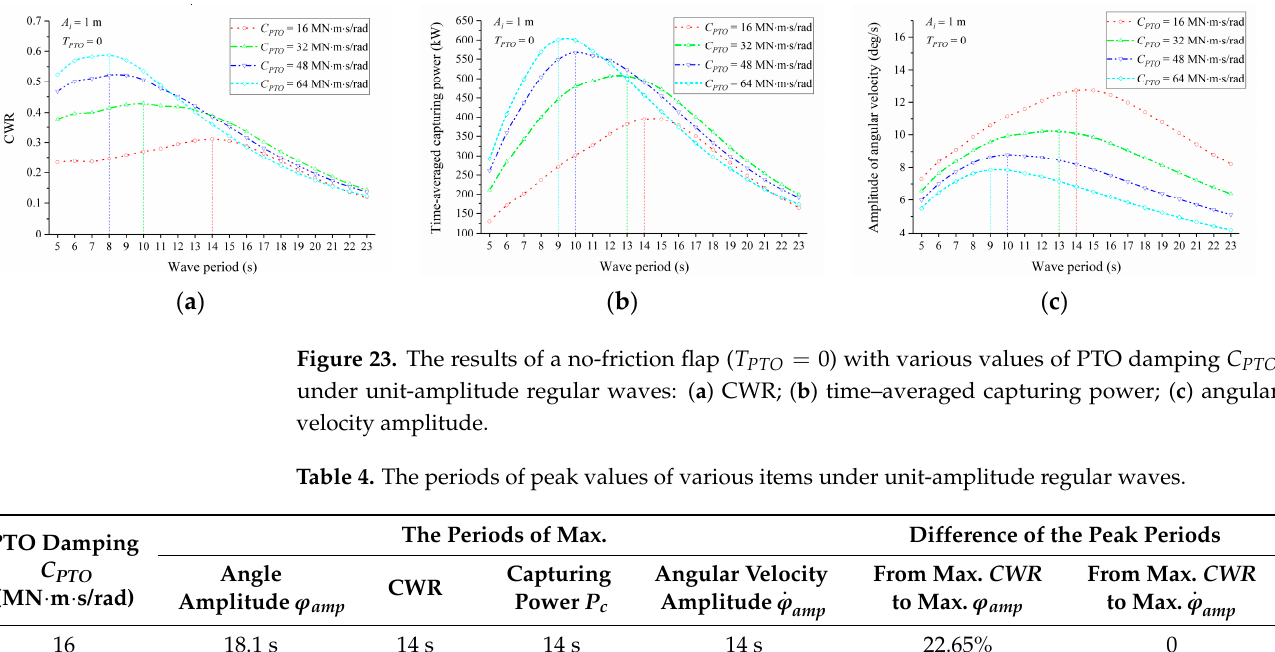
Figure 22. Time–history of the ratios of wave exciting moment and angular velocities of a no-friction flap ( 𝑇 (cid:3017)(cid:3021)(cid:3016) = 0 ) for various values of PTO damping under unit-amplitude regular waves: ( a ) 𝑇 =